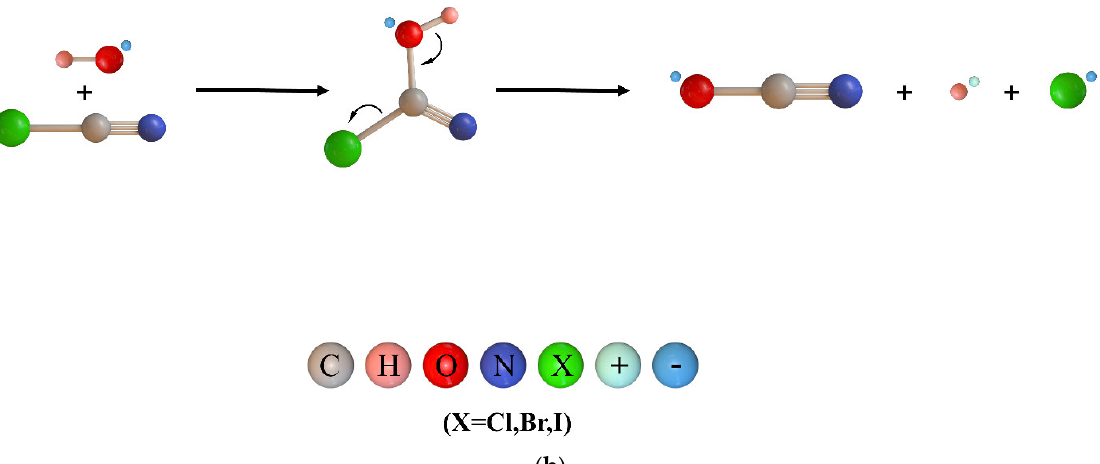
Figure 3. Schematic of CNX hydrolysis: ( a ) disproportionation reaction; ( b ) reaction in highly alkaline solution.